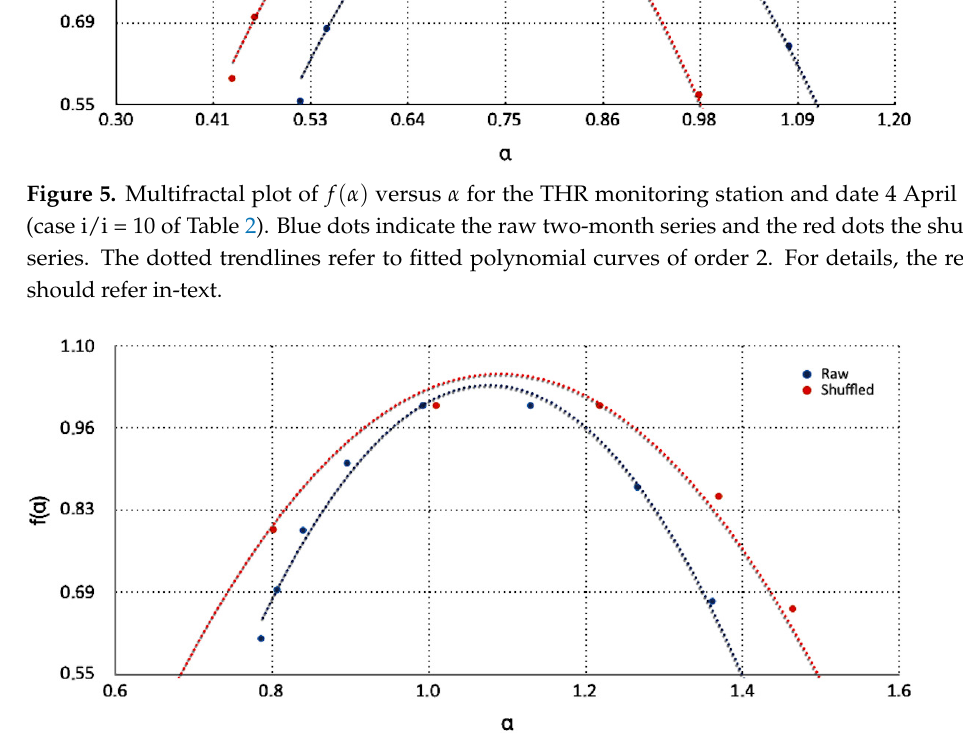
Figure 6. Multifractal plot of f ( α ) versus α for the THR monitoring station and date 6 February 2015 (case i/i = 11 of Table 2). Blue dots indicate the raw two-month series and the red dots the shuffled series. The dotted trendlines refer to fitted polynomial curves of order 2. For details, the reader should refer in